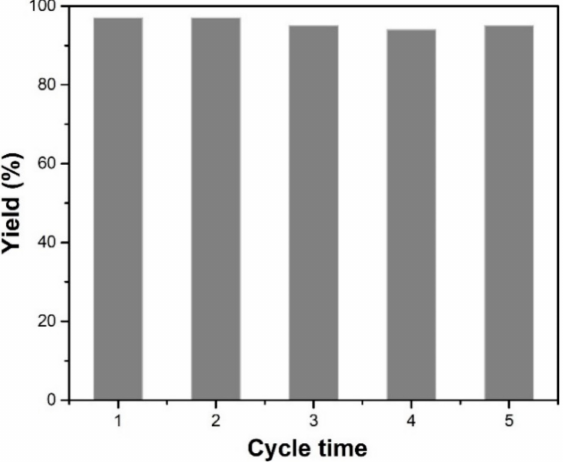
Figure 8. Yields of hydrogenolysis product from lignin model compound using recycled Pd-Fe 3 O 4